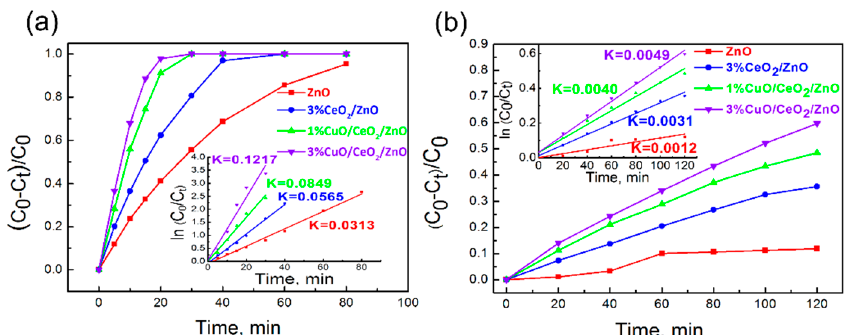
Figure 5. ( a ) Photocatalytic degradation curves of MB and the K -values investigated under UV light irradiation. ( b ) Photocatalytic degradation curves of MB and the K -values investigated under visible light ( λ > 400 nm). Irradiation time: 120 min.